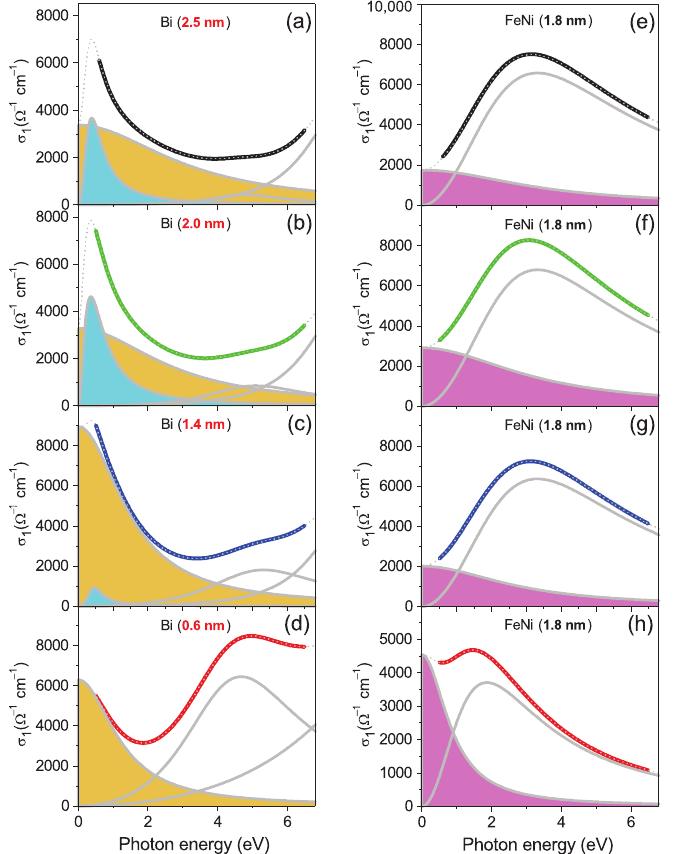
Figure 5. The intralayer optical conductivity, σ 1 ( ω ) = ε 2 ( ω ) ω [ cm − 1 ] /60, for the ( a – d ) Bi layers and ( e – h ) FeNi layers in the [Bi( d )–FeNi(1.8nm)] 16 structures shown for the Bi layer nominal thickness values d = 2.5, 2.0, 1.4, and 0.6nm by solid curves ( a , e ) black, ( b , f ) green, ( c , g ) blue, and ( d , h ) red, respectively. The contributions from the Drude term and the Lorentz oscillator in ( a – d ) are displayed by the yellow- and cyan-shaded areas. In ( e – h ), the Drude term for the FeNi layers is displayed by the magenta-shaded area. Shown by the dotted curves are the summary of the Drude and Lorentz